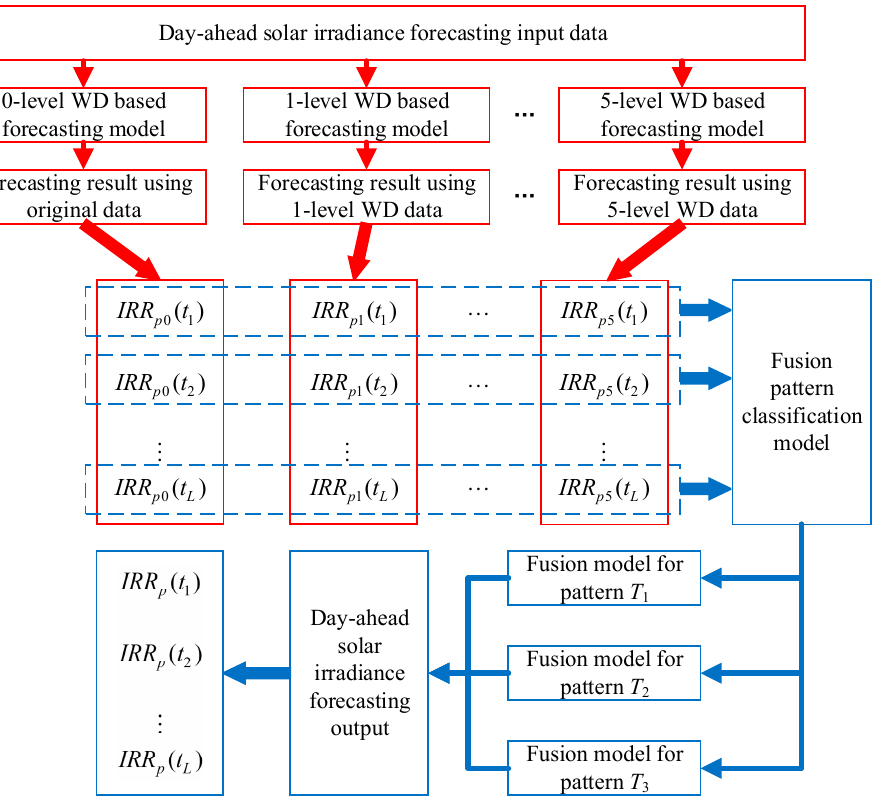
Figure 4. The framework of the proposed time-section fusion pattern classification based day-ahead solar irradiance ensemble forecasting model.